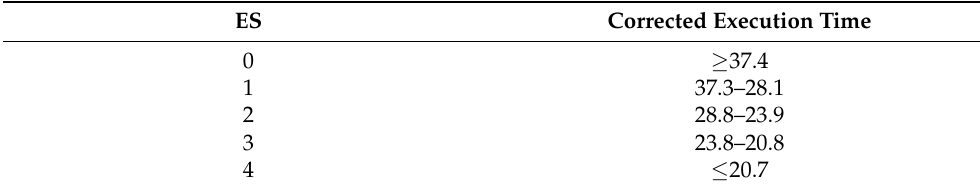
Table 11. Equivalent scores for corrected execution